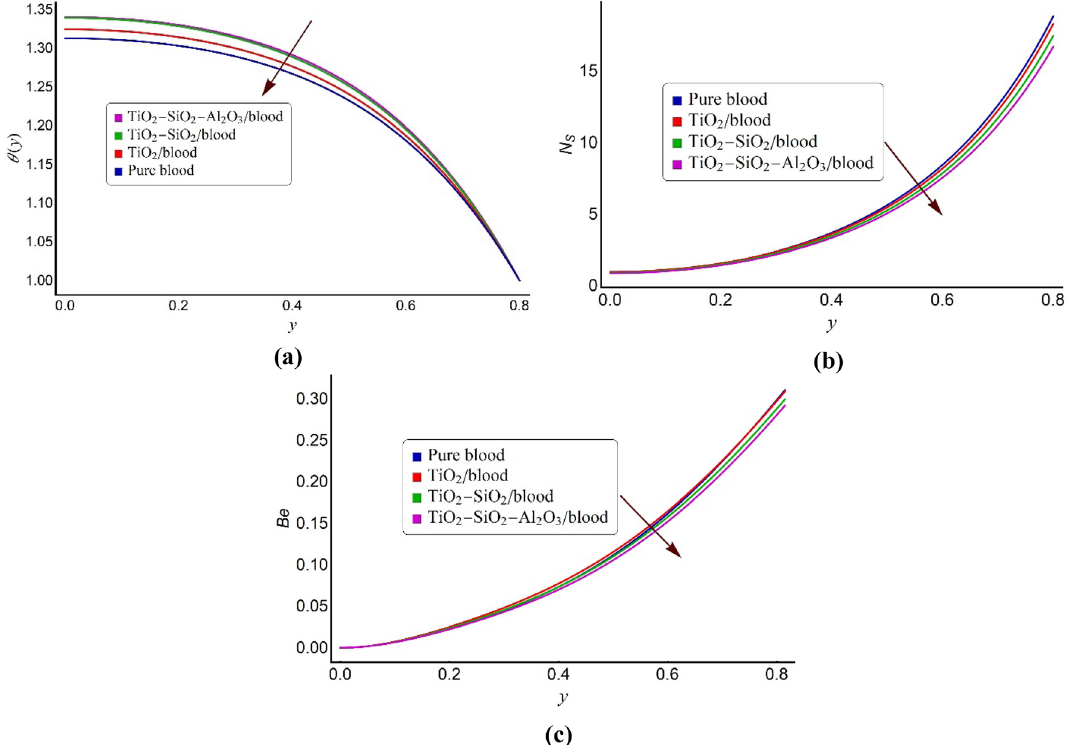
Figure 8. A comparative glimpse of tri-metallic/bi-metallic/mono-metallic nanofluid and conventional blood model for ( a ) the temperature distribution, ( b ) the entropy formation number, ( c ) the Bejan number profile.